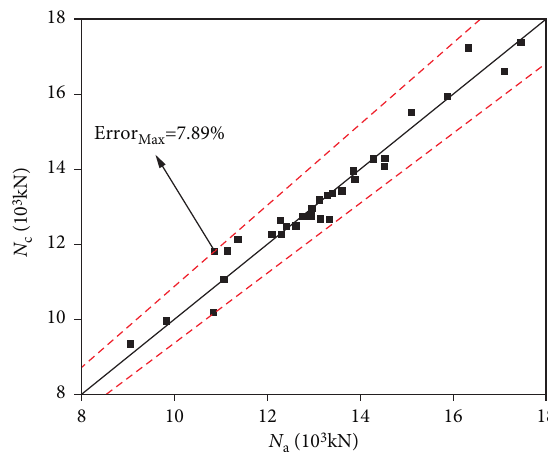
Figure 18: Comparison between N